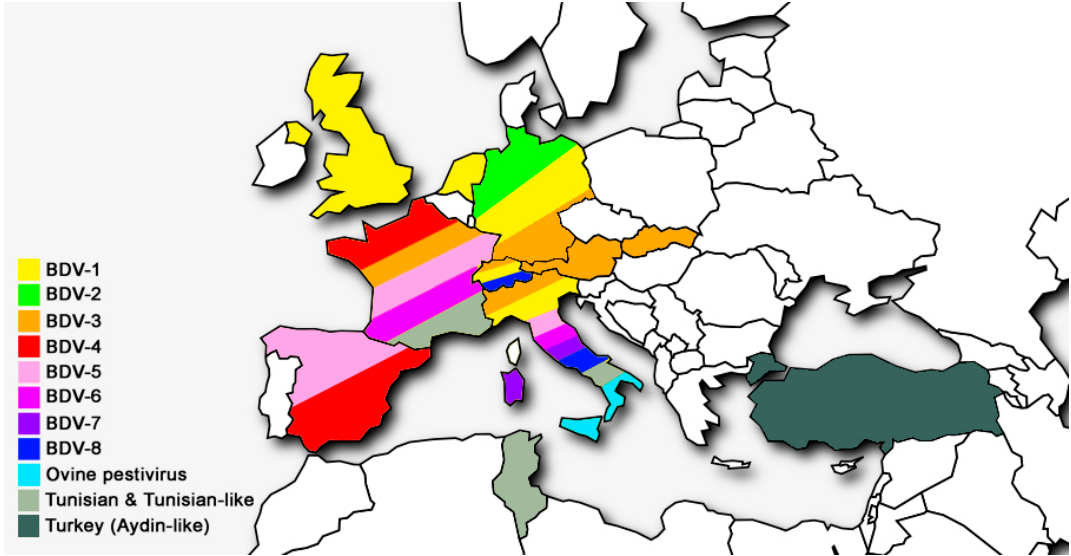
Figure 3. Geographical distribution of BDV genotypes in Europe and in the Mediterranean basin.